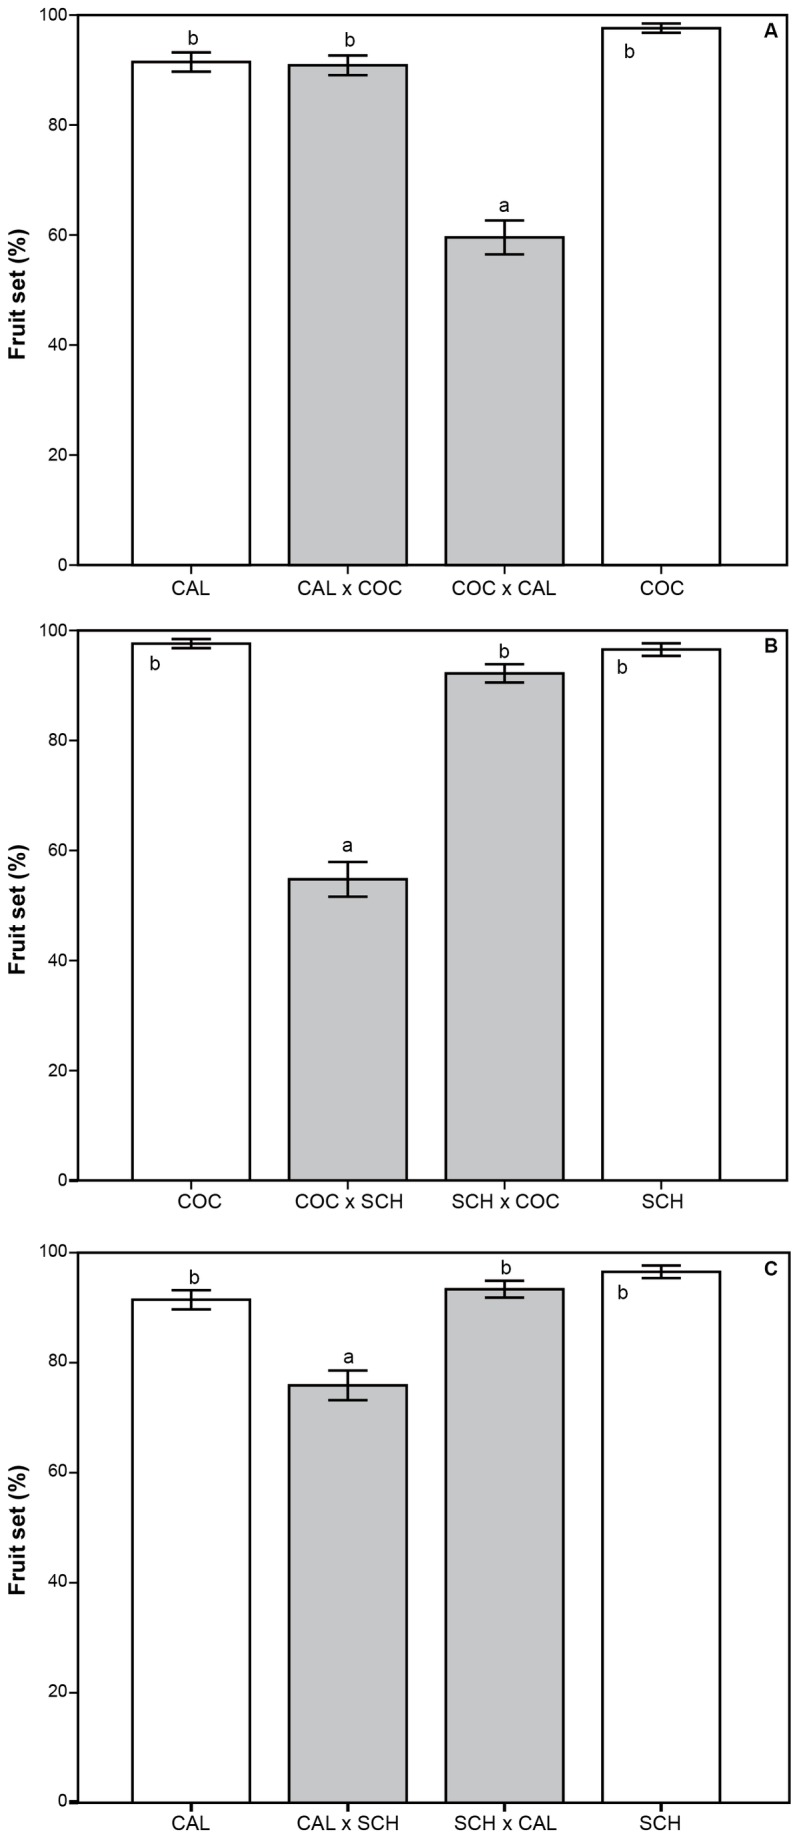
Mean fruit set after experimental crosses within (white bars) and between (grey bars) the studied species considering three pairs of hybridizing species of Epidendrum: E. calanthum x E. cochlidium; (A); E. cochlidium x E. schistochilum (B); E. calanthum x E. schistochilum (C).Values indicate means ± SD (N = 100 plants/cross). The first letters indicate the identity of the mother species: CAL = E. calanthum; COC = E. cochlidium; SCH = E. schistochilum. Crosses with the same letter did not differ significantly (P > 0.05).